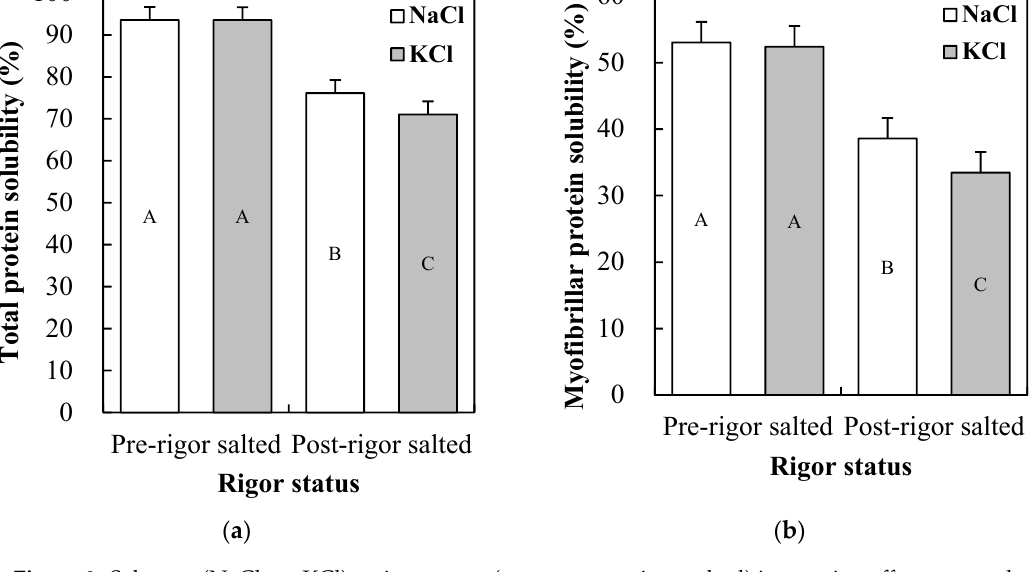
Figure 2. Salt type (NaCl vs. KCl) × rigor status (pre- vs. post-rigor salted) interaction effects on total ( a ) and myofibrillar protein solubility ( b ) of salted chicken breasts. Error bars represent standard error of the means. A–C: means with the same letter are not significantly different ( p ≥ 0.05).